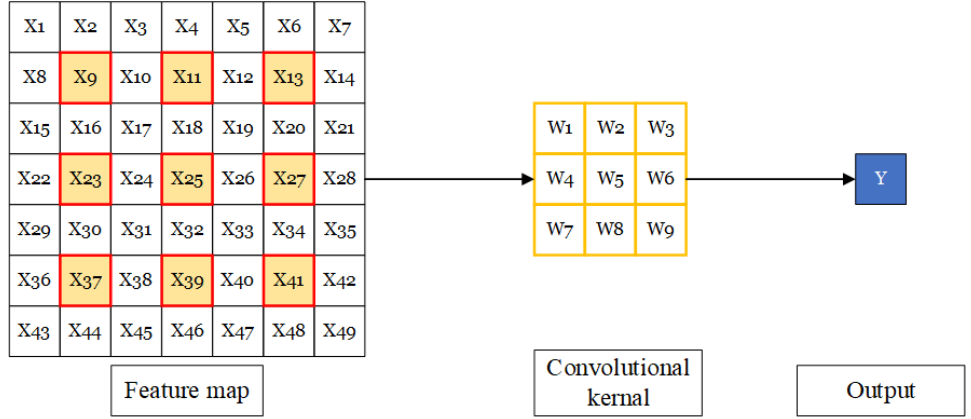
Figure 11. A dilated convolutional operation with a size of 3 × 3 and a dilation rate of 2.